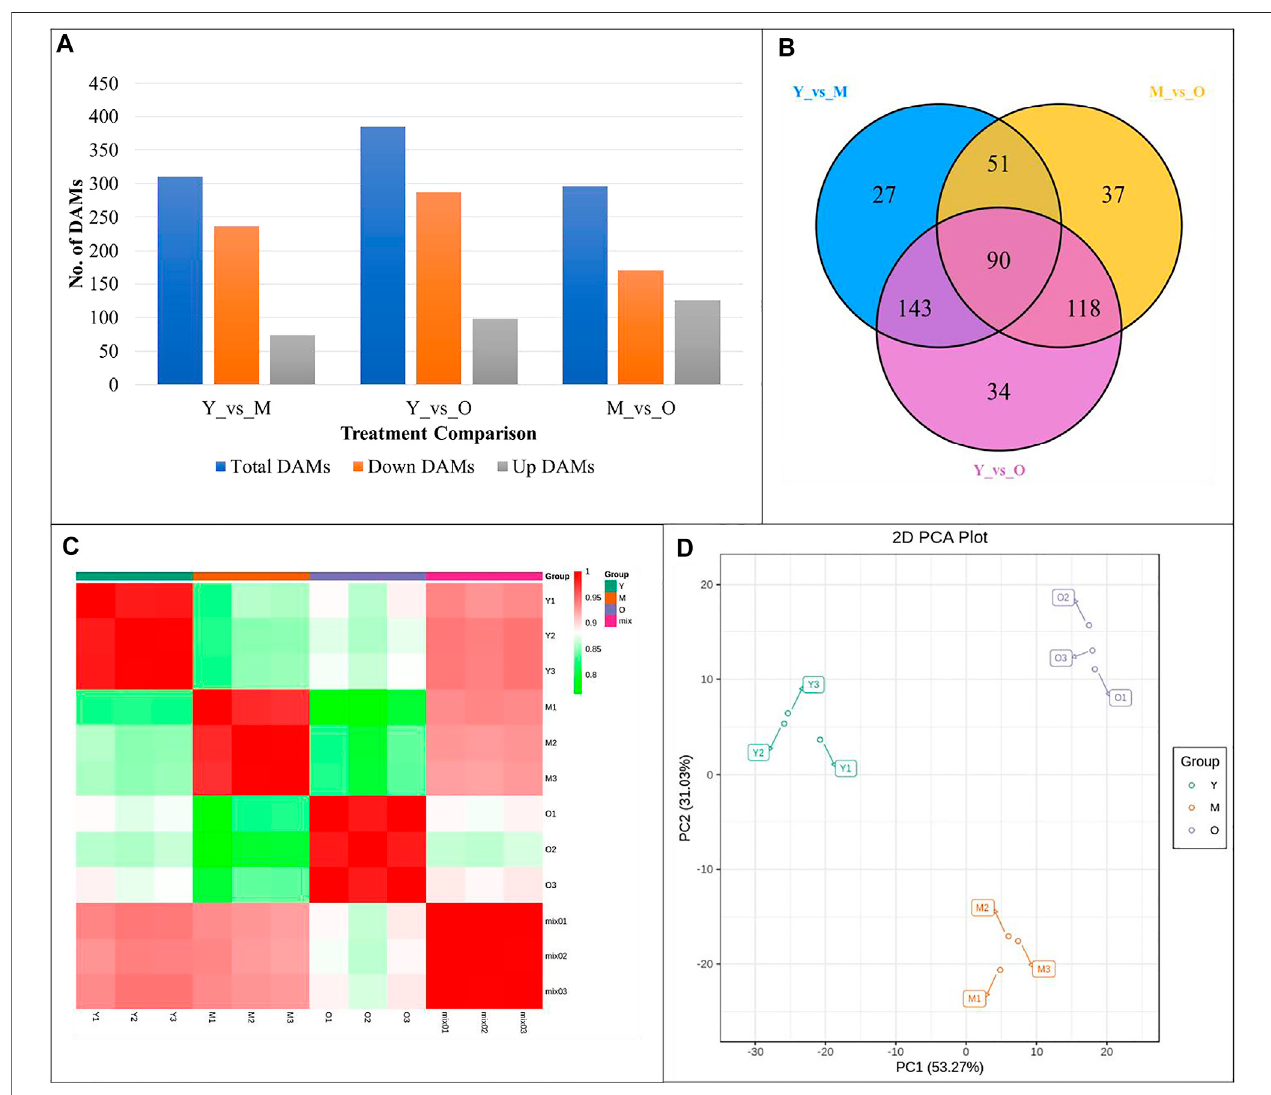
FIGURE7|(A) Summary, (B) Venndiagram, (C) Pearson ’ sCorrelationCoef fi cient,and (D) PrincipalComponentAnalysisofdifferentiallyaccumulatedmetabolites in different ginger rhizome tissues. Y (cid:1) young, M (cid:1) mature, O (cid:1) old ginger rhizome. 1, 2 and 3 with the tissue name represent the